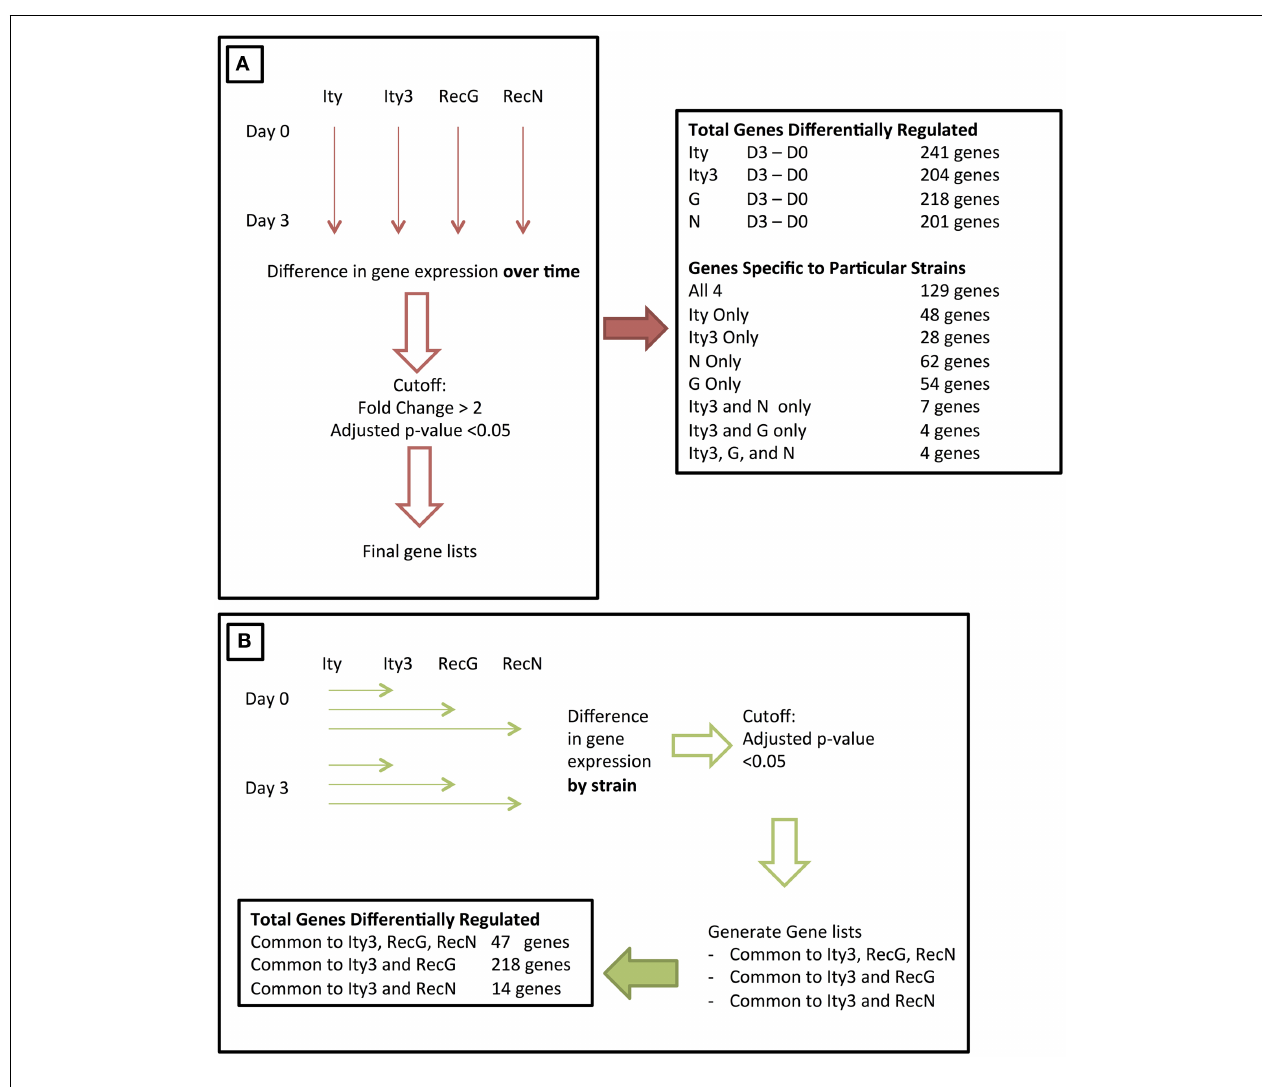
final number of genes differentially regulated is stated on the right. (B) The second approach used, where gene expression in each strain was compared to the control Ity strain, at both day 0 and day 3.The final number of genes within each category is shown at the bottom of the